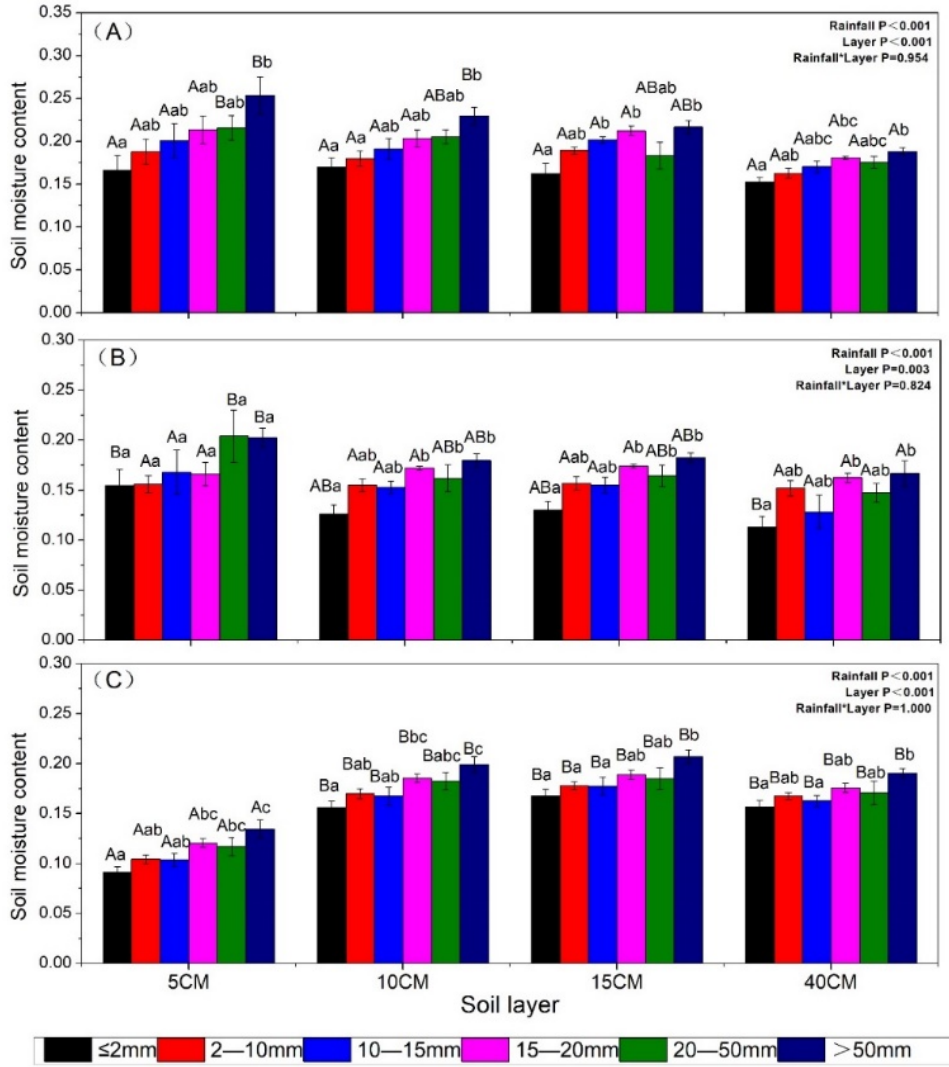
Figure 8. Average moisture content in grassland, Q. acutissima , and C. lanceolata following different rainfall intensities. (Note: Upper case letters indicate significant differences between various soil layers under the same rainfall intensity ( p < 0.05); lower case letters indicate significant differences between different rainfall intensities of the same soil layer ( p < 0.05); ( A ): grassland; ( B ): Q. acutissima ; ( C ): C. lanceolata ; land types: p <